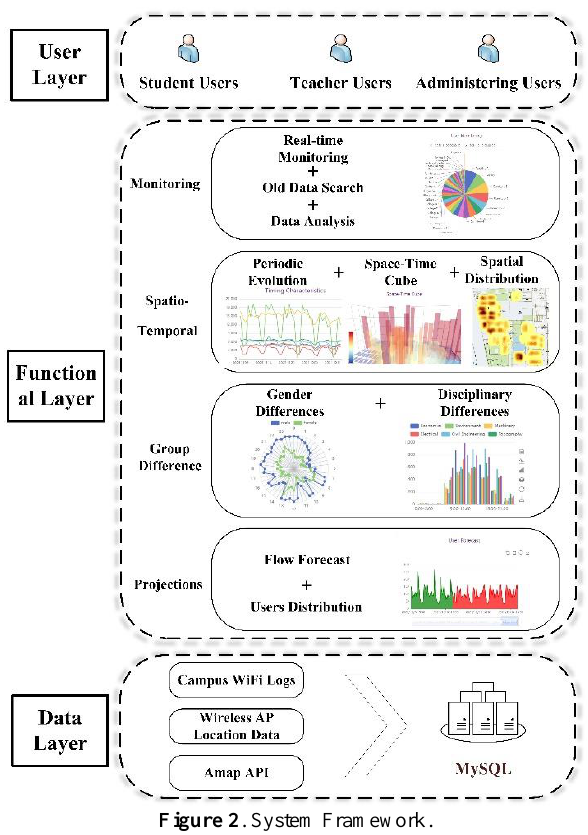
Figure 2 . System Framework.